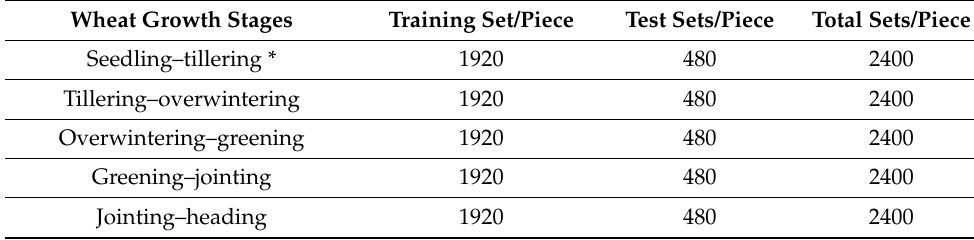
Table 1. Number of wheat canopy image samples.